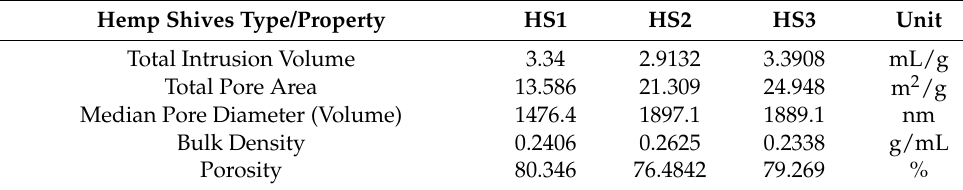
Table 1. Structure characteristics determined by mercury porosimetry.